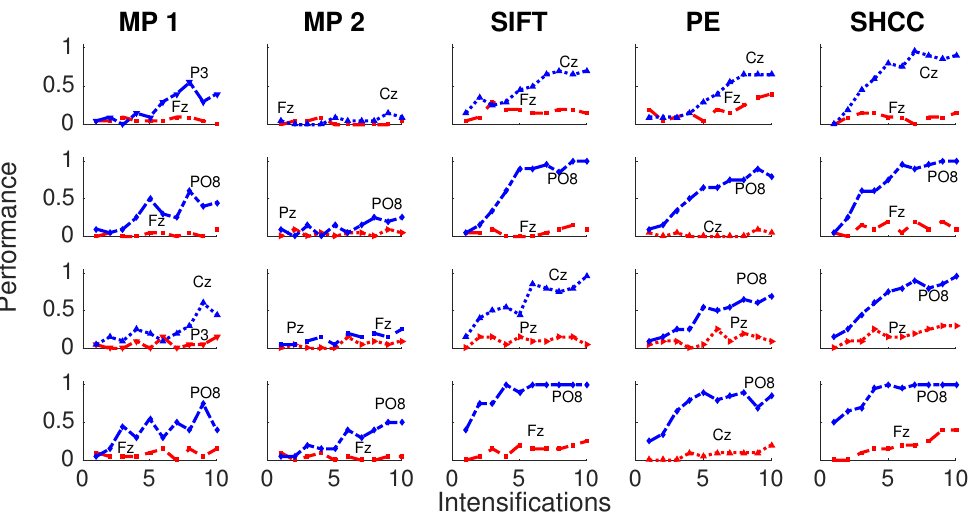
Figure 10. Passive Modality—Experiment 3:Performance curves for four subjects for the five algorithms when the amplitude of the P3b component of the template is randomly